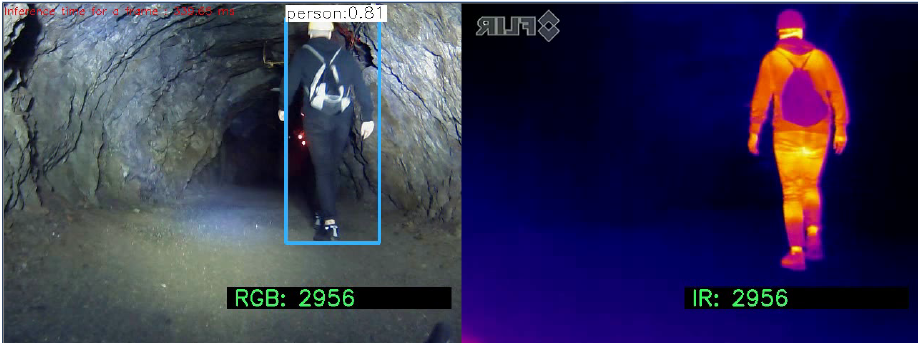
Figure 22. Human standing rear view—no detection with algorithm YOLO.